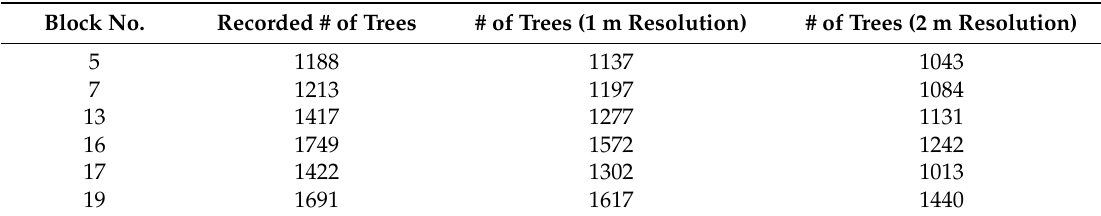
Table 3. Number (#) of trees within the test blocks based on the farm managers records compared to results of the Individual Tree Crown (ITC) segment analysis for 1 m and 2 m height rasters. Block No.